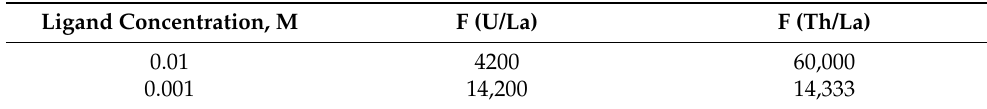
Table 1. Separation factors of the pairs of uranium(VI)—lanthanum(III) and thorium(IV)—lantha- num(III).